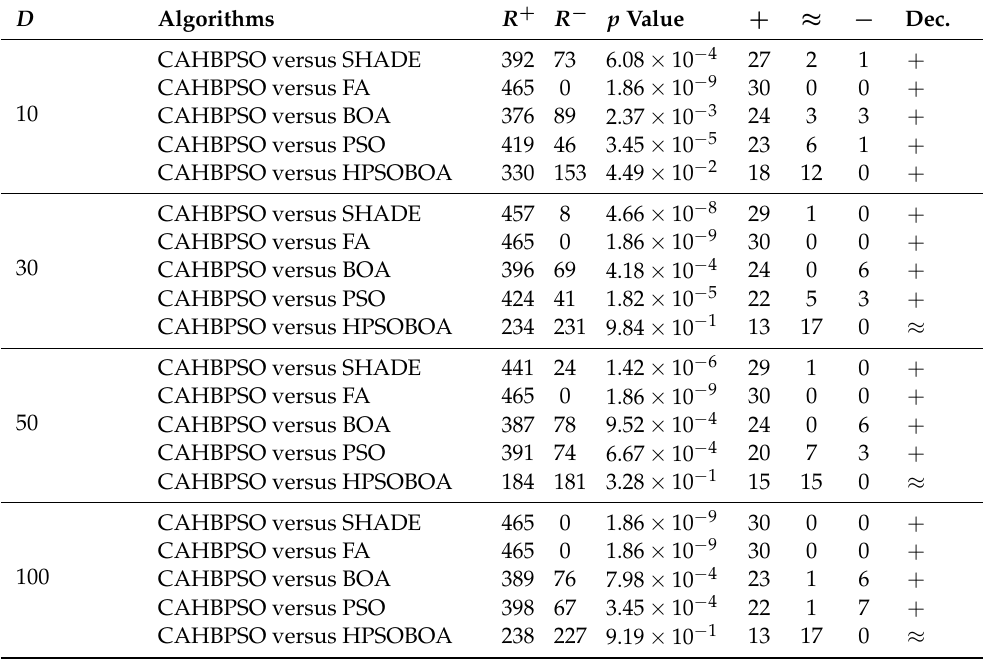
Table 2. Wilcoxon test results for D = 10,30,50, and 100 obtained using CAHBPSO and other evaluated algorithms on a set of CEC2014 benchmark problems.